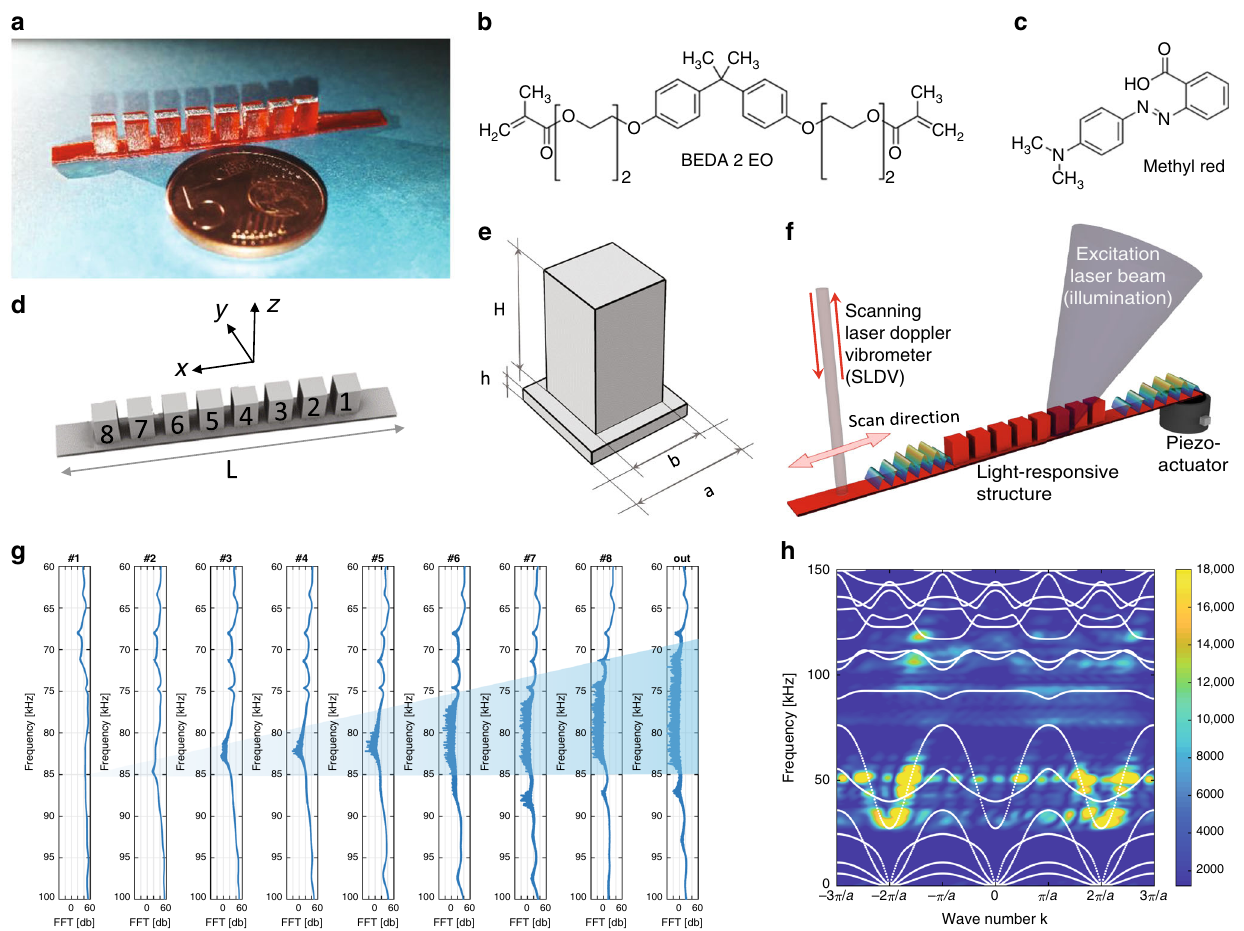
Fig. 1 LRMM concept and spectral response without illumination. a Picture of the LRMM patterned with periodic square pillars. b Molecular structures of the azopolymer and c the UV-curable resin used for fabrication. d Isometric view in the x-direction of the numerical design of the waveguide. e Schematic representation of the unit cell of the periodic pattern: a = 5 mm, H = a , h = a /10 and b = 0.75 a . f Sketch of the experimental con fi guration in which a piezo- actuator excites elastic waves in the slab, a 405 nm laser beam is used to induce a spatially selective photo-softening effect depending on the illumination area and a 633 nm laser vibrometer scans the whole structure while detecting point-by-point the out-of plane oscillation amplitude (SLDV). g Spectral response measured along the pillar array, when elastic waves within a broadband frequency range are excited at one edge of the specimen. A clear progressive drop of the oscillation amplitude on top of each individual pillar is observed at frequencies within the band gap (blue-shaded region), as the scanning laser of the vibrometer moves toward the edge opposite to the excitation source. h Measured dispersion curves of the photo-responsive elastic waveguide at without illumination, superposed to the calculated band structure (white lines). The design of the unit cells allows the nucleation of a frequency band gap centered at about performing a temporal and spatial Fourier Transform (2D-FT) of pillar size, geometry and material properties, namely density and signals collected along the longitudinal x -direction of the pillar elastic modulus, chosen identical for each pillar in our case. array. To this end, signals are collected along a line, with a spatial The photo – softening effect mentioned above is fi rst observed resolution of 0.1 mm during the transient propagation of elastic on a single pillar by measuring the corresponding illumination- waves injected according to a Hanning-modulated sine function dependent frequency response. More speci fi cally, the out-of- (3 cycles) centered at f 0 = 75 kHz. Results are presented in Fig. 1h plane velocity of a propagating wave generated through an as a color map indicating the frequency and momentum coordi- excitation with a fl at spectrum in the 75 – 95 kHz frequency range nates in which the elastic energy is mainly distributed over the fi rst at the input slab edge is collected at the center of the upper three Brillouin zones. Numerically calculated dispersion curves are surface of pillar #1, during laser exposure. As shown in Fig. 2a, superimposed to the experimental measurements as white lines, the pillar spectral response (i.e., the FFT amplitude of the signals revealing the elastic wave propagation occurs according to the pass reported on the z -axis of the fi gure) is fi rst measured without bands supported by the patterned waveguide, while a negligible illumination (red curve) and then at increasing laser power elastic energy is propagated within the BG frequency range. (10 mW steps). A frequency down-shift of the principal resonance peak located at 81 kHz is clearly observed, accom- panied by a progressive attenuation of the oscillation amplitudes at higher frequencies (around 90 kHz), for increasing illumina- Tuning and recovery of the LRMM spectral response . Each tion intensities. The down-shift and amplitude attenuation of pillar contributes to the overall structure response as an indivi- the resonances are expected after the polymer photosoftening. dual oscillator, whose multiple eigenmodes are determined by